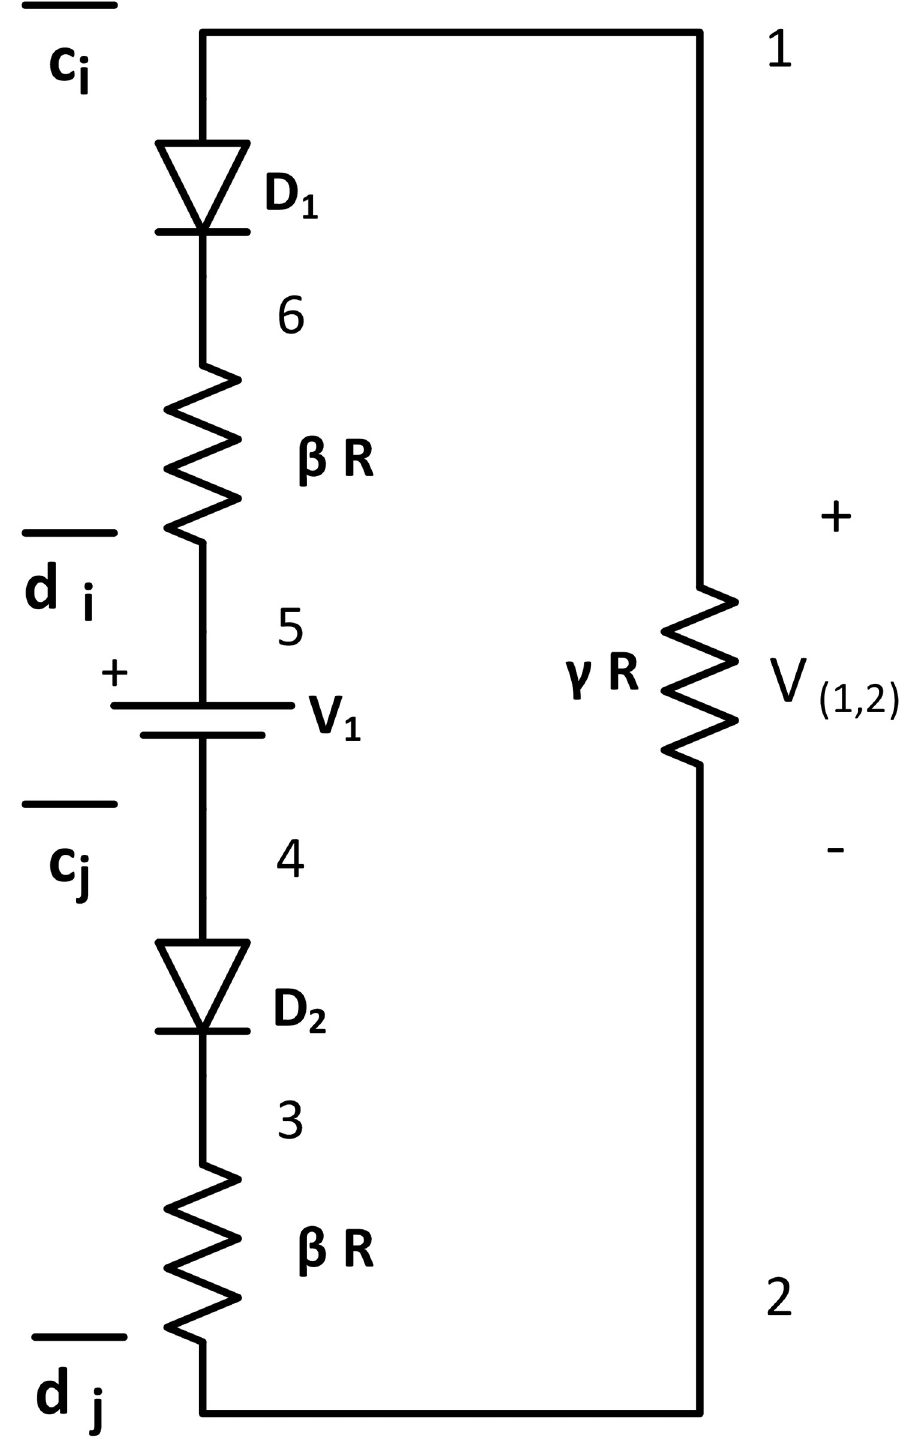
Fig 6. AND tile. AND tile consists of two ideal diodes D 1 and D 2 with V thr = τ , two large value β R resistors, one large value γ R resistor, and one DC voltage source V 1 = τ . It has input nodes across node pair {1, 5} and {4, 2}, and output node at {1, 2}. Glues: g ð 1 Þ ¼ f � c